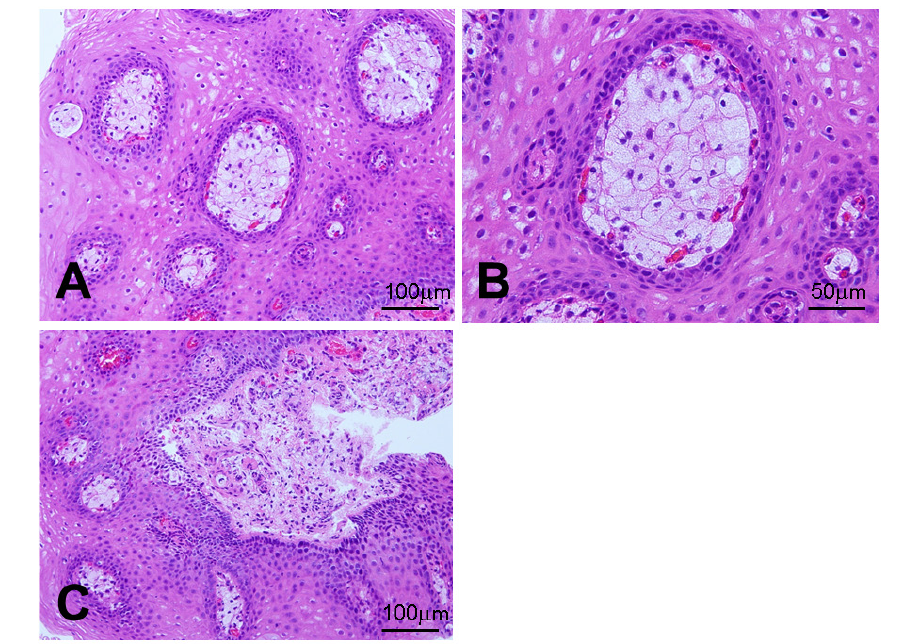
Figure 2: Histological findings of esophageal xanthoma. (A) Various sized aggregations of foam cells are found in the papillae (x200, HE). (B) The foam cells have small round-shaped nuclei located at the periphery of the cytoplasm, and have abundant granular cytoplasm (x400, HE). (C) In the deep submucosal layer, some lymphocytes and histiocytes are noted, however, acute inflammatory findings, such as neutro- philic infiltrate, edema, and small vessel formation, are not noted (x200, HE)